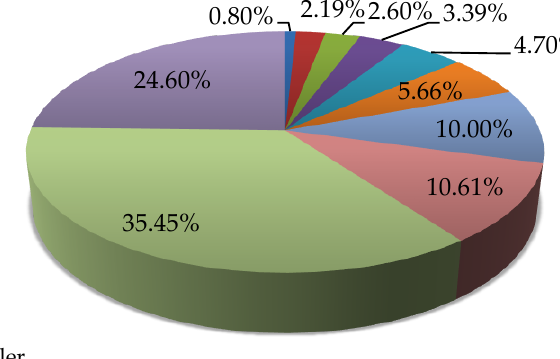
( b ) Figure 7. Boiler fuels divided by: ( a ) boiler class; ( b ) kind of fuel. Own research based on [60]. The declarations of the owners/administrators of residential buildings give rise to the conclusion that boilers using a solid fuel constitute 35.45% of all sources of heat. In 24.60% of the declarations, the following heat sources were referred to: gas boiler, flow-through